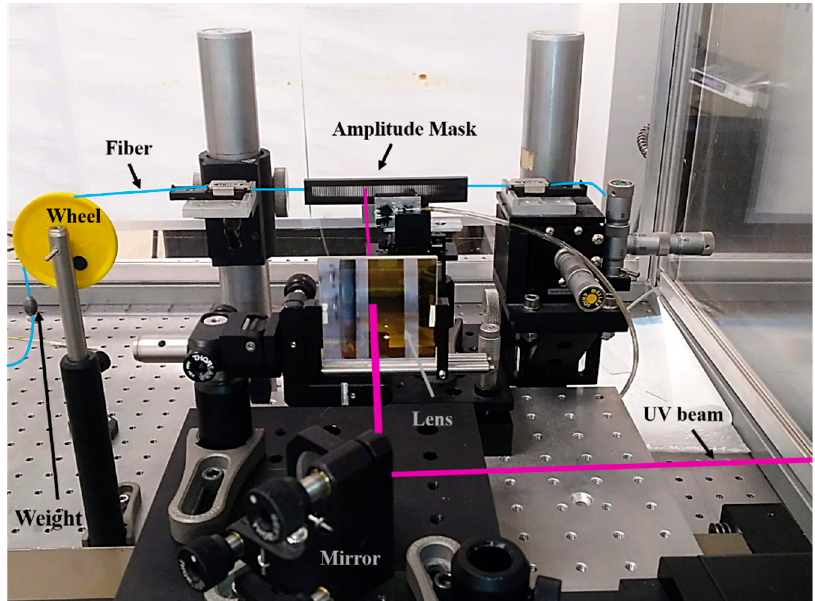
Figure 2. Picture of the setup used for the UV inscription of long-period gratings (LPGs) through the amplitude mask technique. The laser beam is guided through mirrors, focused by a cylindrical lens, passing through the 3D printed amplitude mask and hitting the optical fiber behind. The weight on the fiber is used to keep the same fiber strain between experiments.